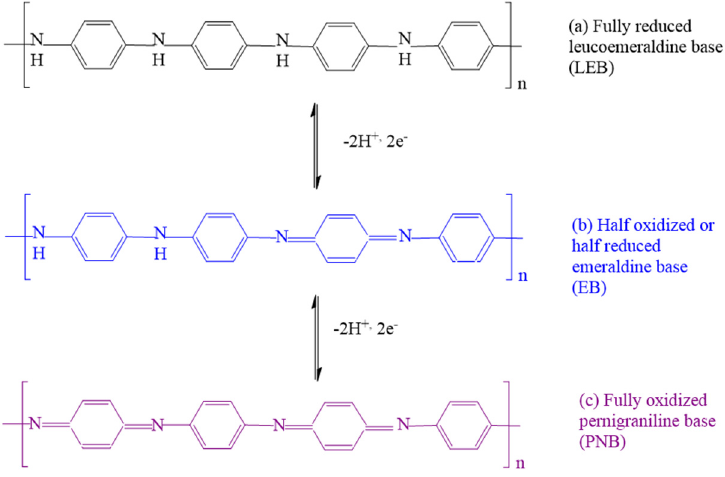
Figure 4. Schematic illustration for the electrochemical reaction mechanism of PANI. The reduction peaks at (0 V and 0.4 V) and oxidation peaks (0.3 V and 0.7 V) of PANI were a tt ributed to the redox conversion of leucoemeraldine to emeraldine (0.3 V and 0 V) and emeraldine to pernigraniline (0.7 V and 0.4 V), respectively [31]. It is clear that rGO as a supercapacitor electrode exhibited pseudocapacitive behavior rather than the typical electric double-layer capacitance with a rectangular CV shape. Figure 3B indicates that the oxygen functional groups in GO were not completely removed by the reduction process.